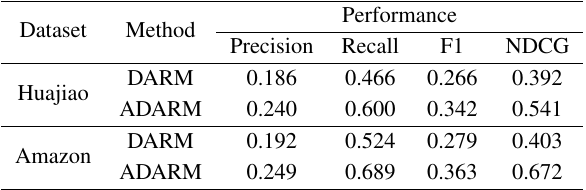
Table 3 Performance of DARM and ADARM for top 5 recommendations.